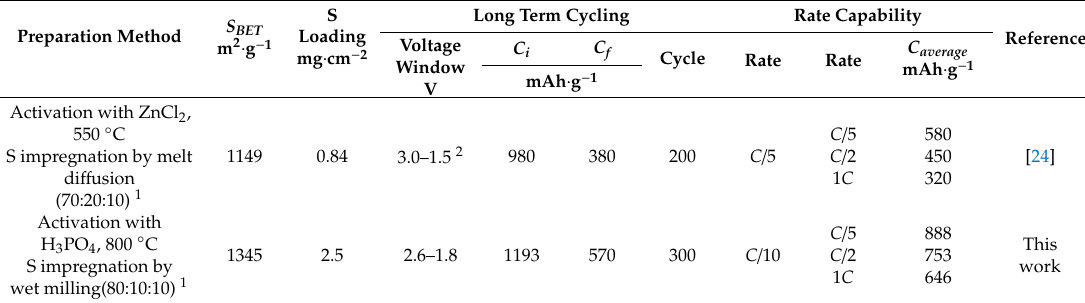
1 Electrode composition (composite:carbon black:PVDF ratio). 2 Voltage window drawn in the figure. In the text, the indicated voltage window is 1.0–3.0 V.